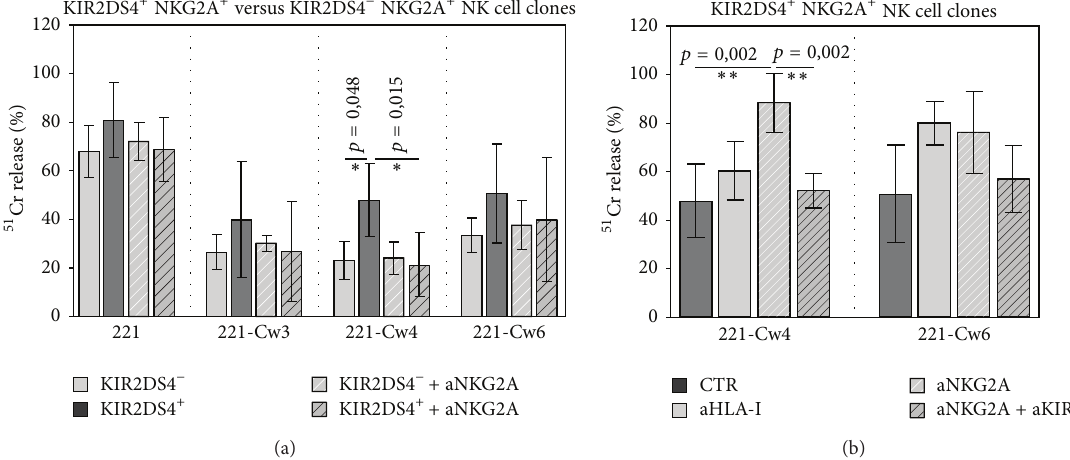
Figure 3: Comparison between KIR2DS4 + and KIR2DS4 − NK cell clones in the killing of transfected 221 cell lines. (a, b) The cytolytic activity of KIR2DS4 − NKG2A + and KIR2DS4 + NKG2A + NK cell clones (derived from a B haplotype donor) was analyzed against untransfected or Cw3-, Cw4-, or Cw6-transfected 221 cells in the absence or in the presence of mAbs to the indicated molecules. The 𝐸/𝑇 ratio used was 1:1. The average of 4 independent experiments and standard deviation (mean ± SD) are indicated. ∗∗ 𝑝 < 0.01 ; ∗ 𝑝 < 0.05